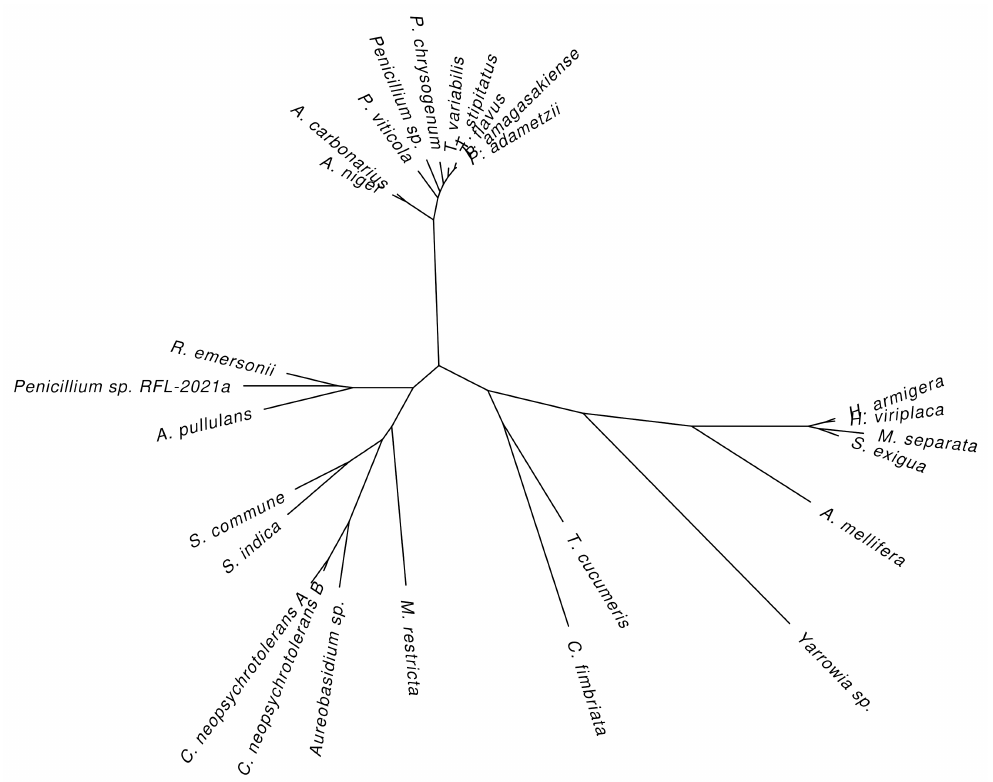
Figure 5. A phylogenetic tree based on an alignment of all sequences given in Table 4. The separation between the insect and fungal GOxes can clearly be seen. Within the fungal group, the Aspergillus, Talaromyces, and most of the Penicillium species cluster in their own clade, while the other species cluster in a different one. This tree was generated by PhyML [91] based on an alignment prepared by Clustal Ω